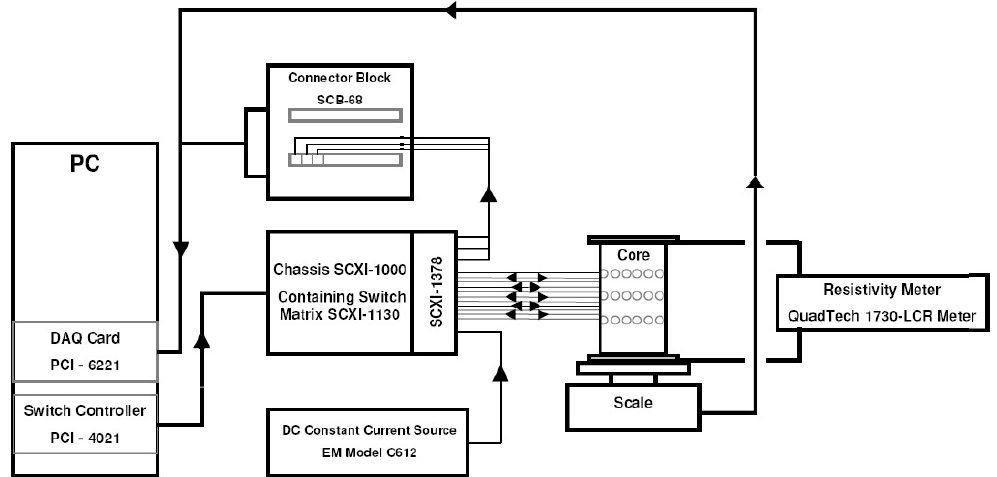
Figure 10. EIT system schematic developed at Stanford